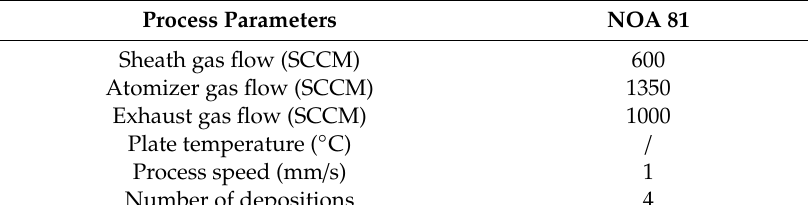
Table 2. Printing process for the photopolymer NOA 81.